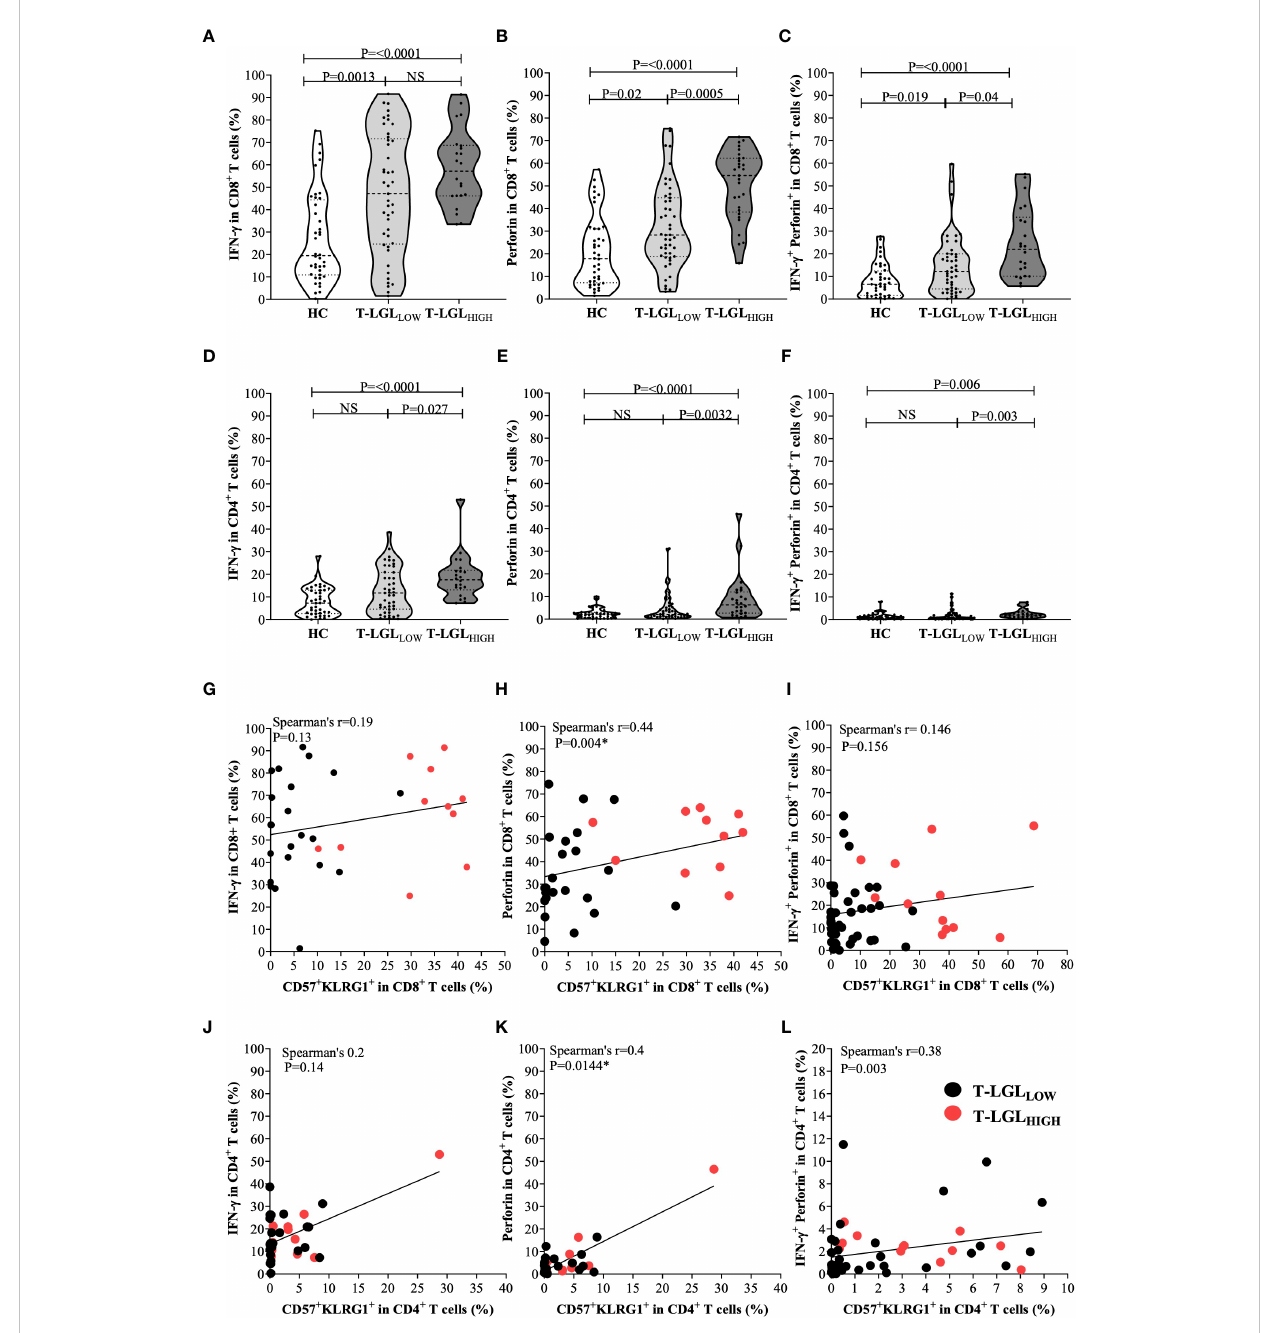
FIGURE 7 In fl ammatory and cytotoxic potential of CD8 + and CD4 + T cells in healthy controls, IBM T-LGL LOW , and IBM T-LGL HIGH . (A) Median frequency of IFN- g in CD8 + T cells HC (n=40), IBM T-LGL LOW (n=45), and IBM T-LGL HIGH (n=22). (B) Median frequency of perforin in CD8 + T cells HC (n=40), IBM T-LGL LOW (n=47), and IBM T-LGL HIGH (n=29). (C) Median frequency of IFN- g + perforin + in CD8 + T cells HC (n=40), IBM T-LGL LOW (n=45), and IBM T-LGL HIGH (n=22). (D) Median frequency of IFN- g in CD4 + T cells HC (n=40), IBM T-LGL LOW (n=45), and IBM T-LGL HIGH (n=22). (E) Median frequency of perforin in CD4 + T cells HC (n=40), IBM T-LGL LOW (n=47), and IBM T-LGL HIGH (n=29). (F) Median frequency of IFN- g + perforin + in CD4 + T cells HC (n=40), IBM T-LGL LOW (n=45), and IBM T-LGL HIGH (n=22). Statistical analysis was performed using Kruskal-Wallis ANOVA and Bonferroni post hoc test for multiple comparisons. The P-values are indicated; NS, Not Signi fi cant. (G) Spearman ’ s correlation between the proportion of CD8 + IFN- g + and CD57 + KLRG1 + cells in T-LGL LOW (n=23) and T-LGL HIGH patients (n=11). (H) Spearman ’ s correlation between the proportion of CD8 + perforin + and CD57 + KLRG1 + cells in T-LGL LOW (n=23) and T-LGL HIGH patients (n=11). (I) Spearman ’ s correlation between the proportion of CD8 + IFN- g + perforin + and CD57 + KLRG1 + cells in T-LGL LOW (n=38) and T-LGL HIGH patients (n=12). (J) Spearman ’ s correlation between the proportion of CD4 + IFN- g + and CD57 + KLRG1 + cells in T-LGL LOW (n=23) and T-LGL HIGH patients (n=11). (K) Spearman ’ s correlation between the proportion